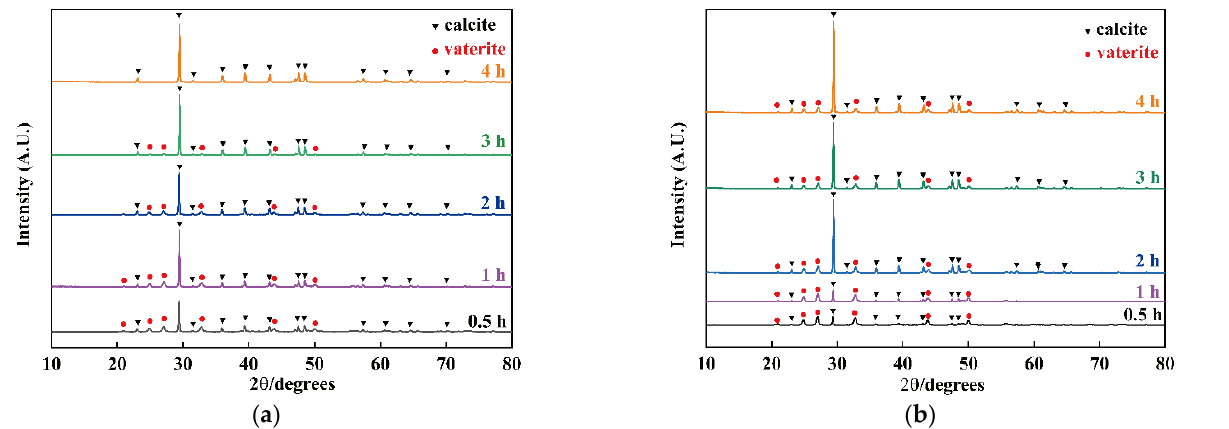
Figure 3. XRD patterns of CaCO 3 particles obtained with different reaction times in deionized water containing nanobubbles ( a ) and deionized water ( b ).